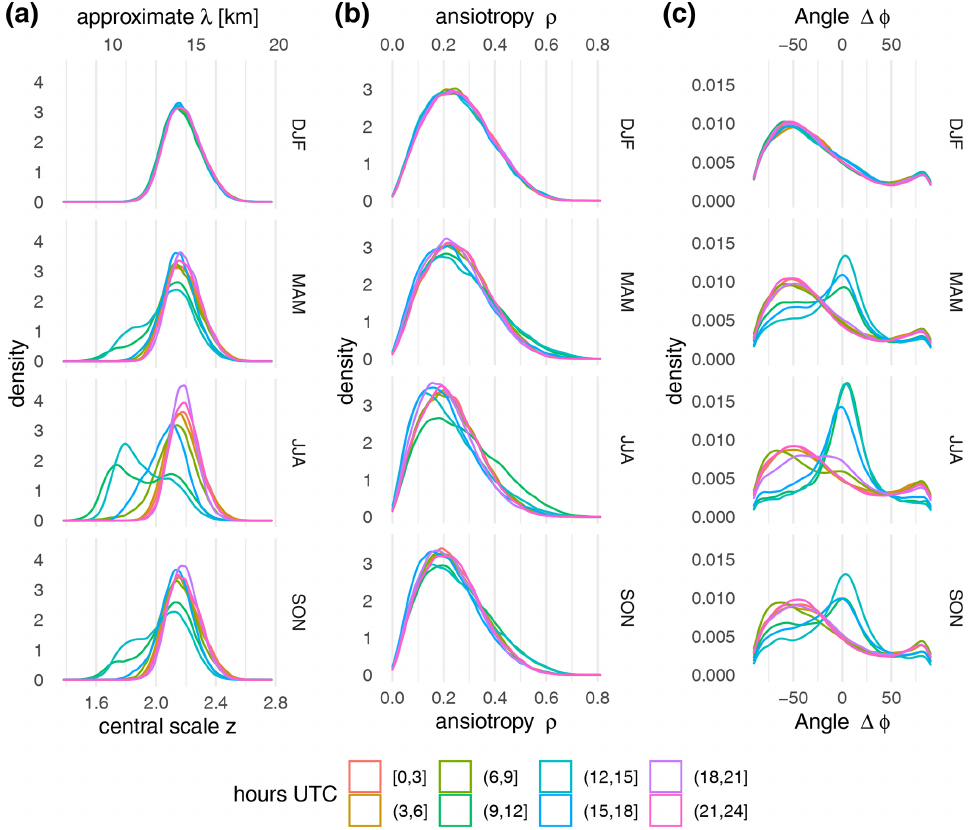
Figure 5. Estimated probability densities (kernel estimates) for the scale z ( a , converted into an approximate wavelength λ via Eq. 2), anisotropy ρ (b) , and relative angle (cid:49)ϕ (c) for different seasons (from top to bottom winter, spring, summer, and autumn) and times of